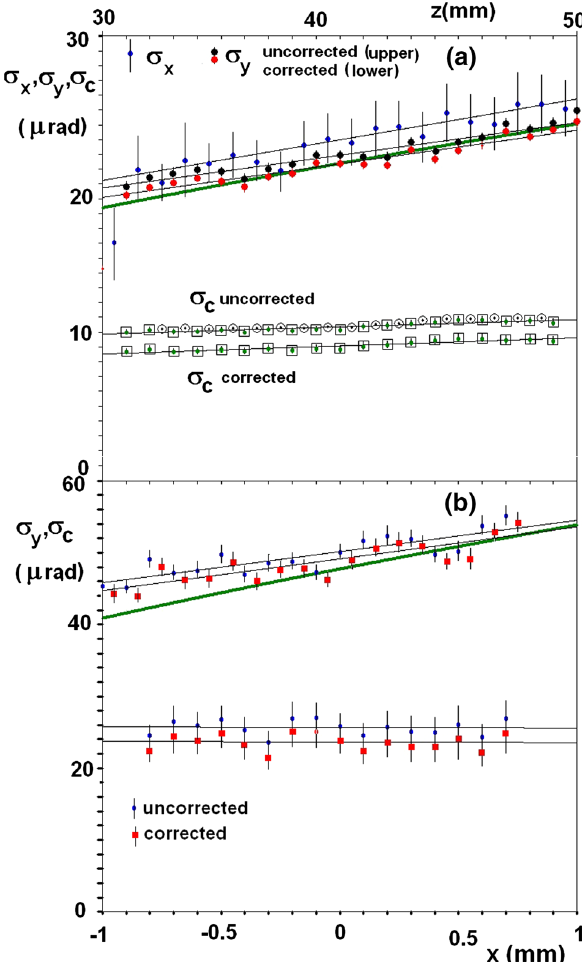
Fig. 5 The σ x , σ y and σ c values as functions of the distance along the crystal (from 30 mm up to 50 mm). The straight lines are linear approximations to the corresponding experimental points. The data are presented for two cases: a beam momentum 400 GeV/c and crystal 1; b beam momentum 180 GeV/c and crystal 2. The lower horizontal scale is the transverse coordinate x and the upper scale is the corresponding longitudinal coordinate z . The meaning of corrected and uncorrected results is explained in the text. The small black squares in a represent Σ c values (as determined in the text). For better visibility, these squares are offset by 0.05 mm. The green curves are calculations accordingly to Eq. (4). The black thin lines are linear approximations of corresponding experimental